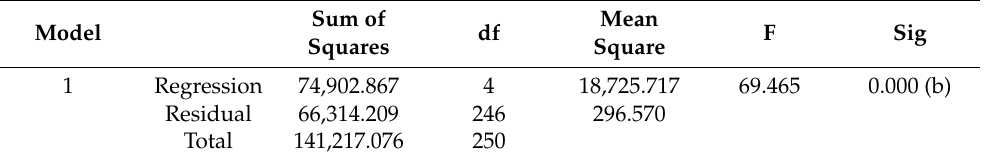
Table A2. ANOVA (a).